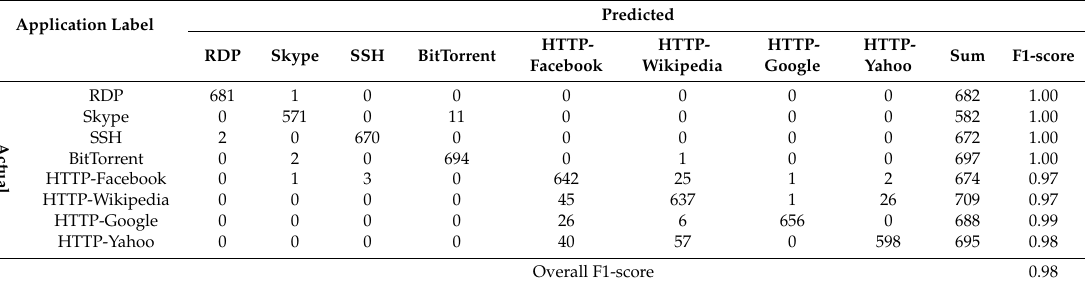
Table 5. The multi-class confusion matrix by the multi-layer LSTM model test with the dataset of 60 sequential packets per flow and 1024 pixels of payload size (The bold line is used to convert this multi-class confusion matrix into the binary confusion matrix of the RDP application label shown in Table 6).